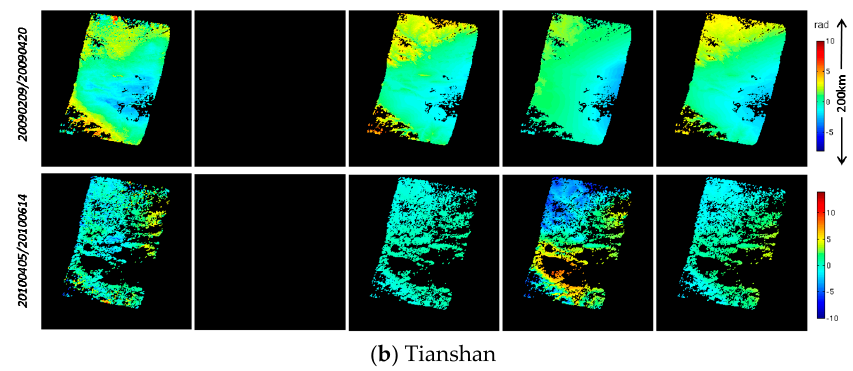
Figure 10. Examples of tropospheric delay estimated by different methods in: ( a ) California; and ( b ) Tianshan. Columns represent the unwrapped interferograms, and the estimated tropospheric delays using MERIS, the linear, ERA-I, and PLE methods (from left to right). All observations are converted to displacements in LOS.